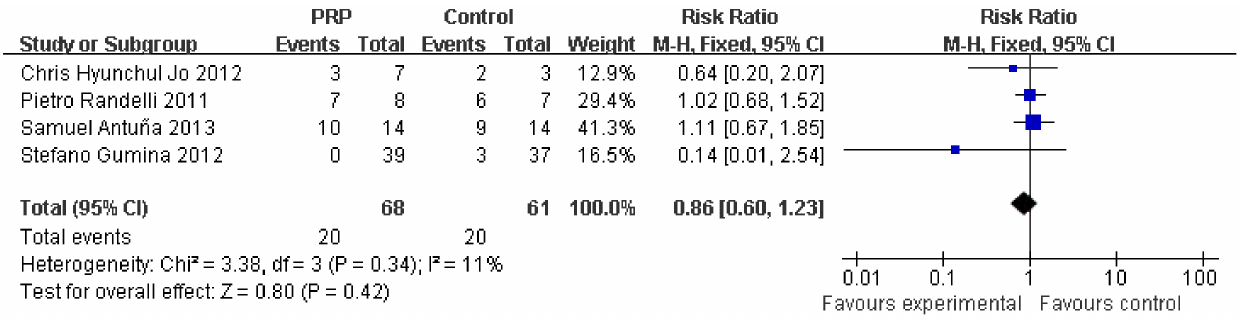
Figure 9. Difference in the retear rate of large- and massive-sized rotator cuff.